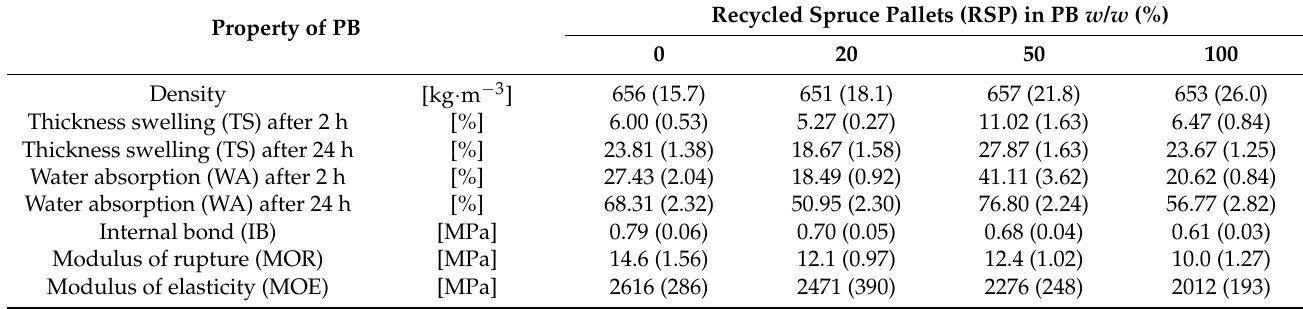
Table 3. Physical and mechanical properties of the reference/control PB (PB-C) and the PBs containing particles from recycled spruce pallets (PB-RSP).